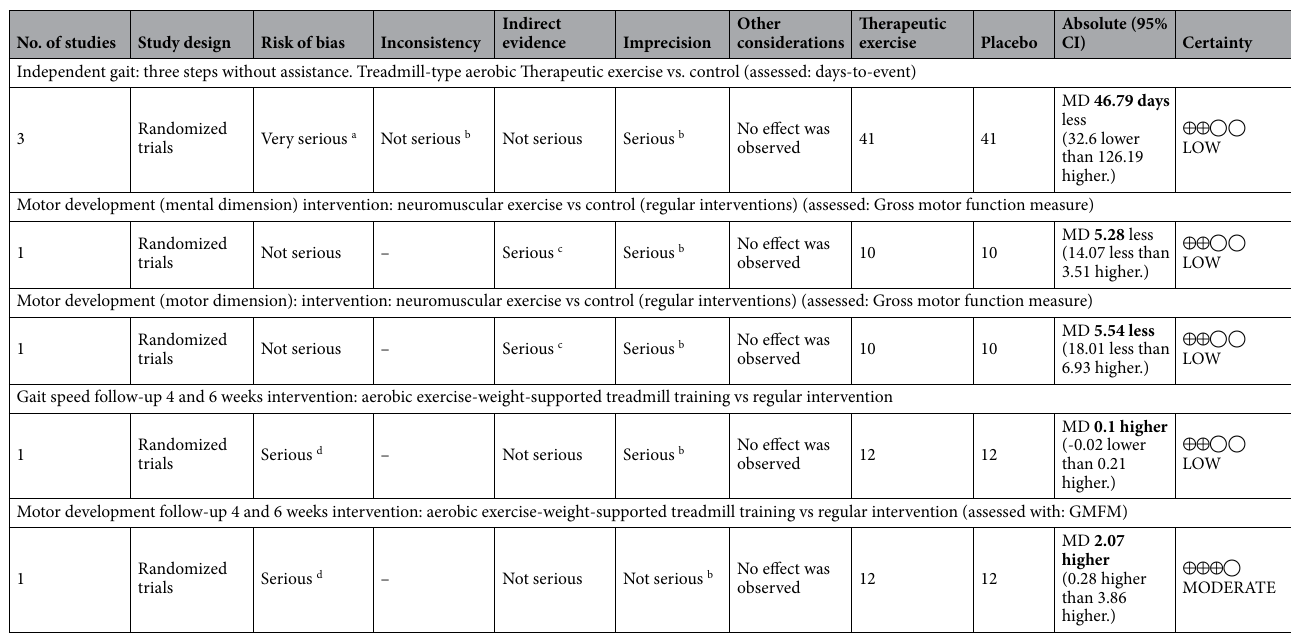
Table 3. Assessing the certainty of the evidence presented for each outcome. MD: mean difference. a The methods of randomization and the blinding of the evaluators are not clear. There is selective and incomplete reporting of results in one of the studies and doubt in the others; b Confidence intervals are wide; they cross the line of no effect. c Population with intellectual disability including Down Syndrome. d The methods of randomization are not